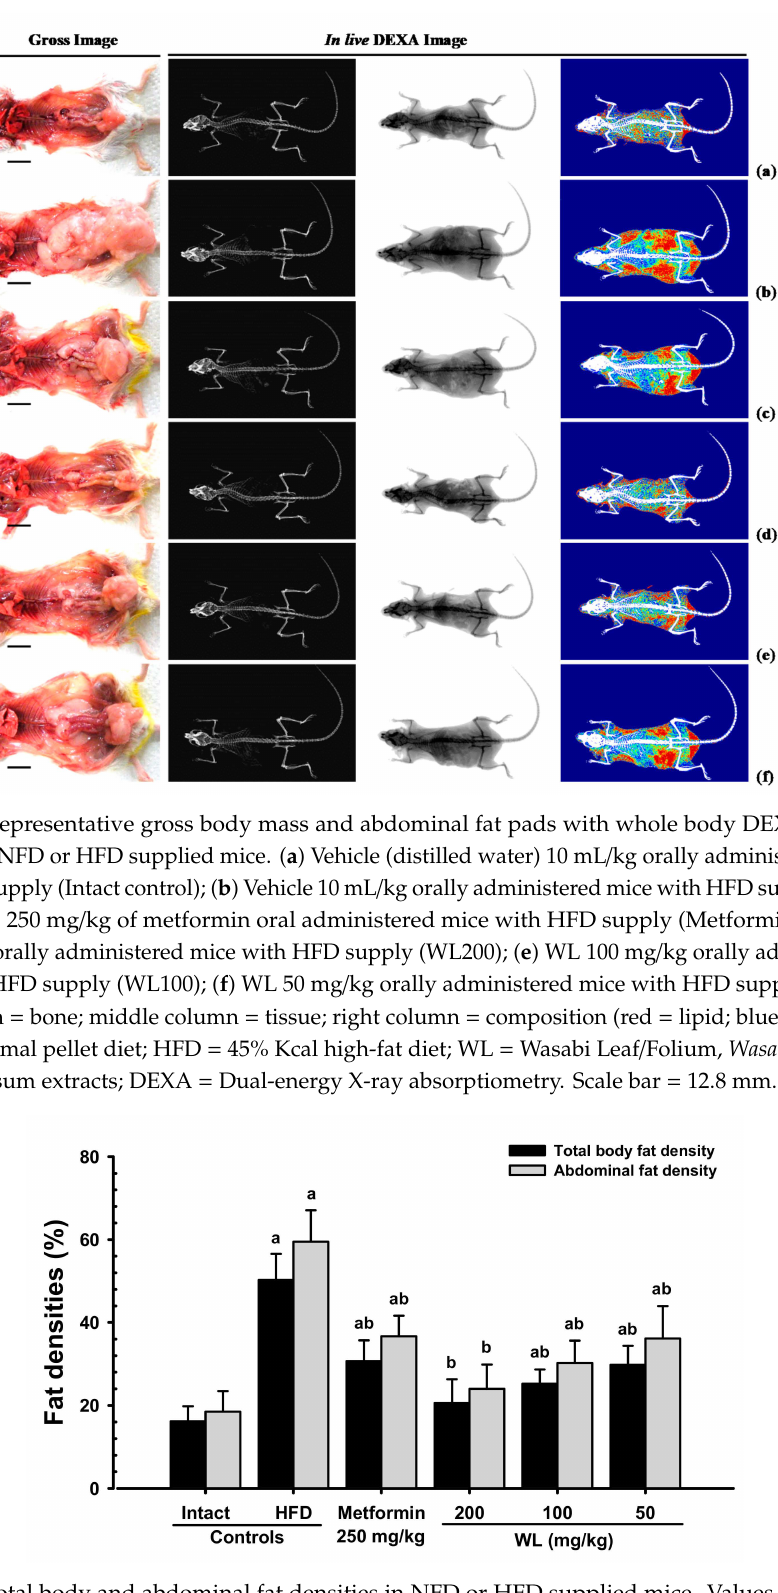
Figure 3. Total body and abdominal fat densities in NFD or HFD supplied mice. Values are shown as mean ± SD of eight mice. NFD = Normal pellet diet; HFD = 45% Kcal high-fat diet; WL = Wasabi Leaf / Folium, Wasabia japonica (Miq.) Matsum extracts. a p < 0.01—vs. intact control; b p < 0.01—vs. HFD